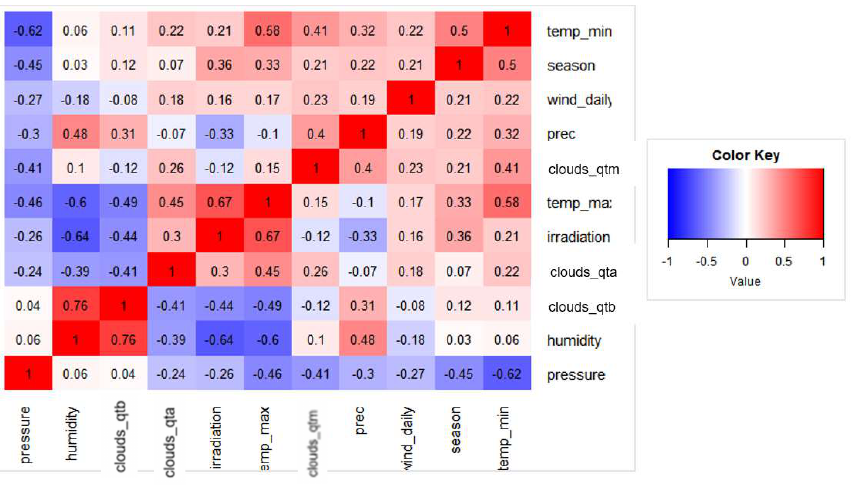
Figure 3. Heat m ap: Spearman correlation matrix.